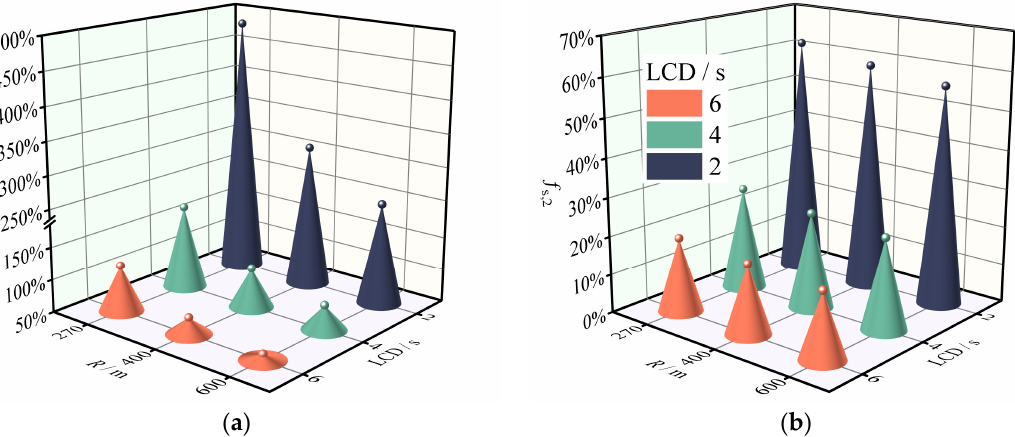
Figure 9. Safety margin reduction rate of the SUV on the horizontal curve and grade combinations under LC_B. ( a ) Sideslip margin reduction rate. ( b ) Rollover margin reduction rate.